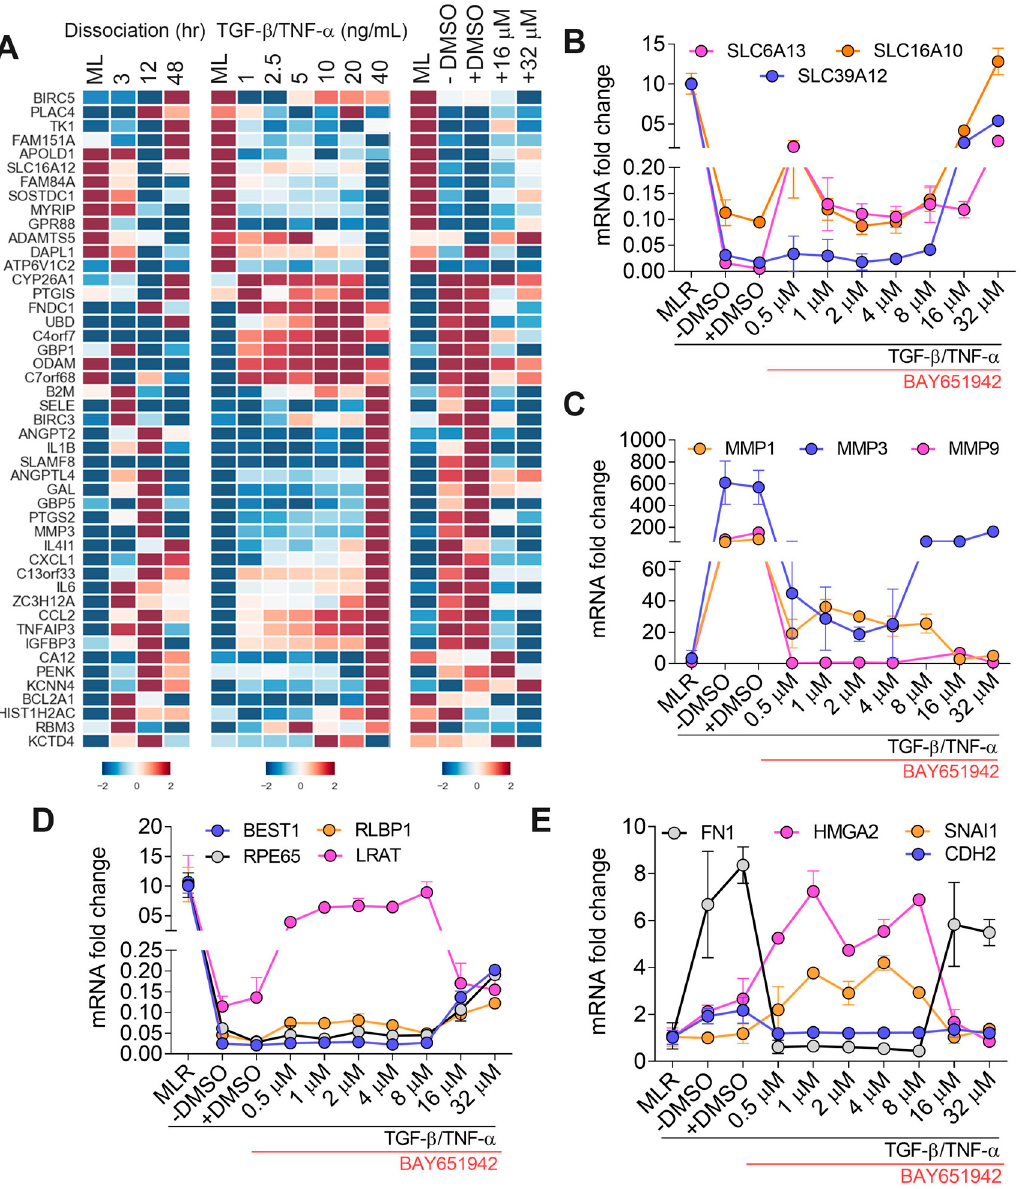
Figure 4. Differential expression of AMD-associated risk factor modulated by BAY651942